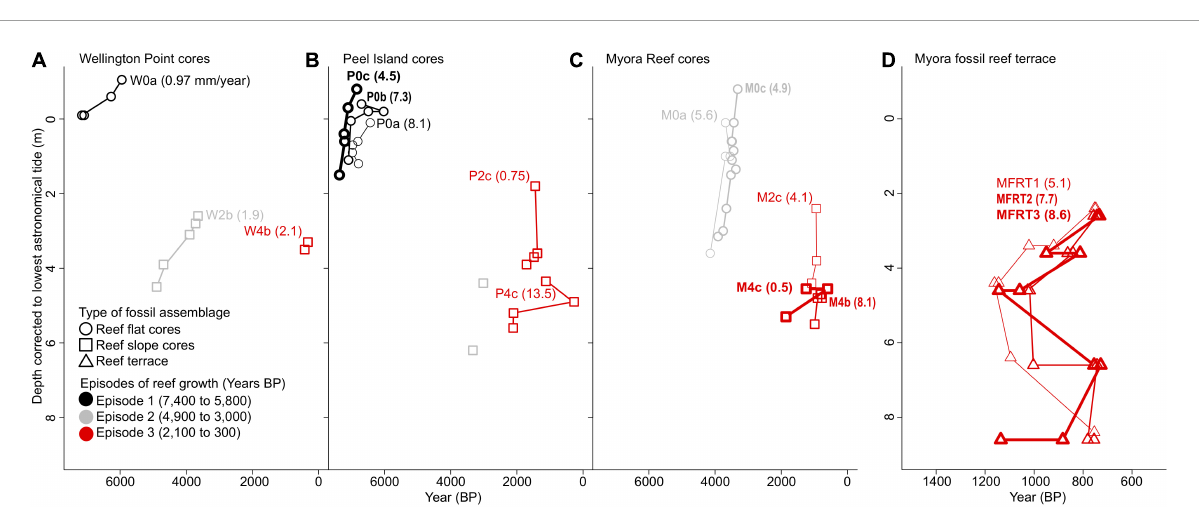
FIGURE3 Age-depth plots showing reef growth and accretion rates from individual reef sediment cores and the submerged fossil reef terrace of: (A) Wellington Point, (B) Peel Island, (C) Myora Reef cores, and (D) Myora fossil reef terrace. Core depths were uncompacted and corrected to lowest astronomical tide (LAT). Note differences in x -axis scale between cores and the Myora fossil reef terrace. Different colors and font styles within site are used to visually differentiate cores and terrace sections. All accretion rates are presented as mm yr - 1